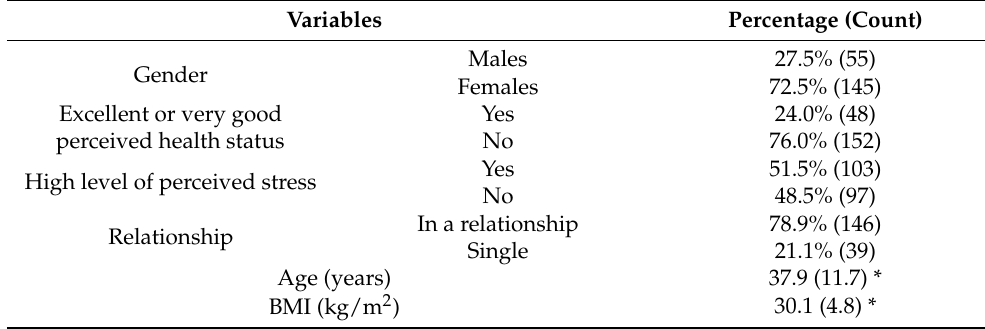
Table 1. Demographic characteristics of the sample ( n =